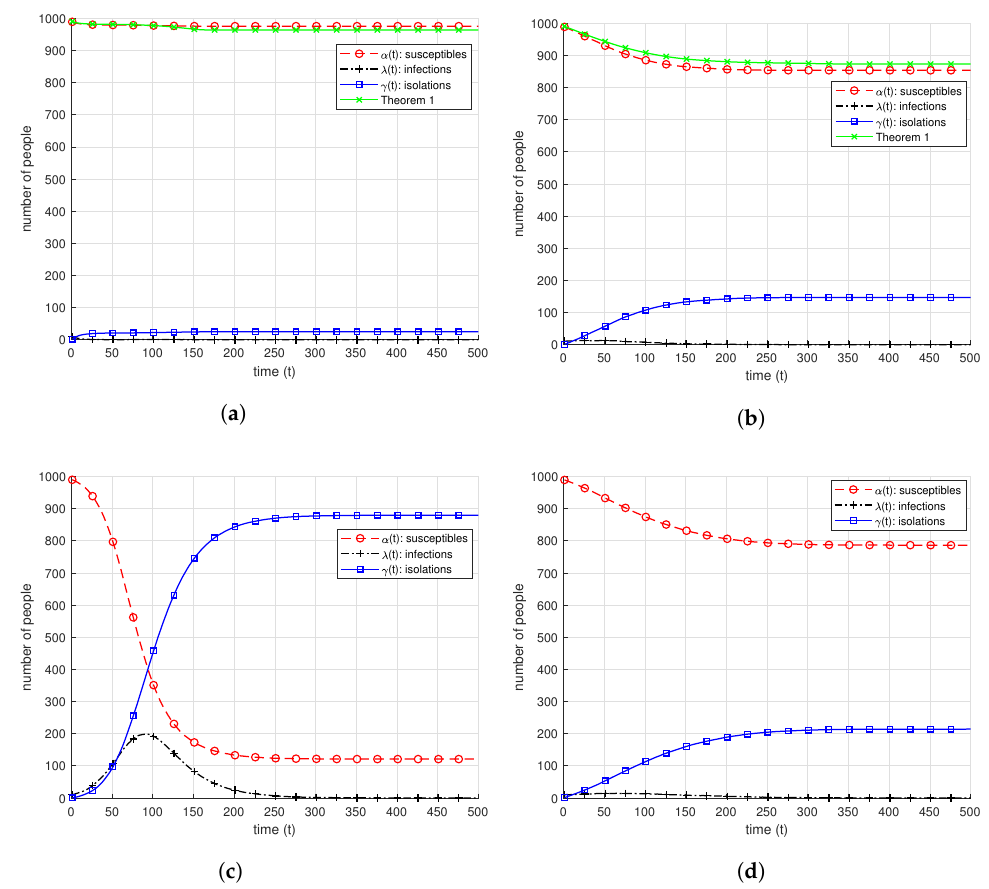
Figure 2. Average values of the random processes α ( t ) , λ ( t ) and γ ( t ) , with obtained theoretical approximations given in Theorem 1 when n = 1000, T = 80, q = 0.0001, p = 0.01, for ( a ) dynamic Dorfman type group testing algorithm, ( b ) dynamic individual testing algorithm, ( c ) weak dynamic Dorfman type group testing algorithm, ( d ) weak dynamic individual testing